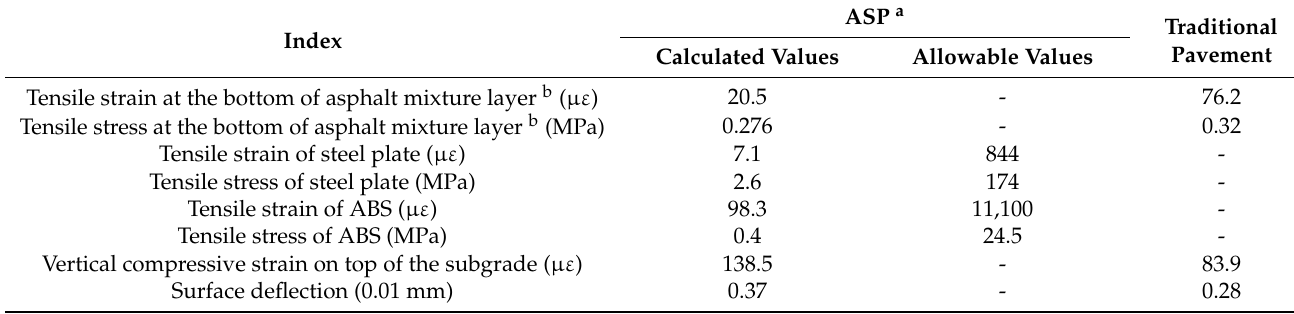
Table 7. Comparison of the mechanical properties of ASP and traditional